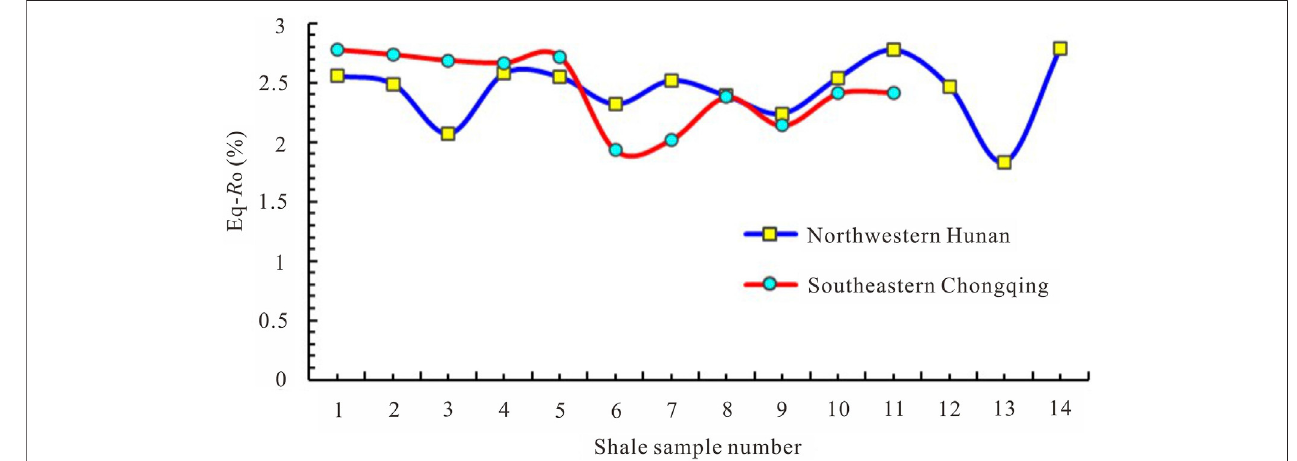
FIGURE 5 | Eq- R o distribution of the Longmaxi shale samples in Chongqing and Hunan.